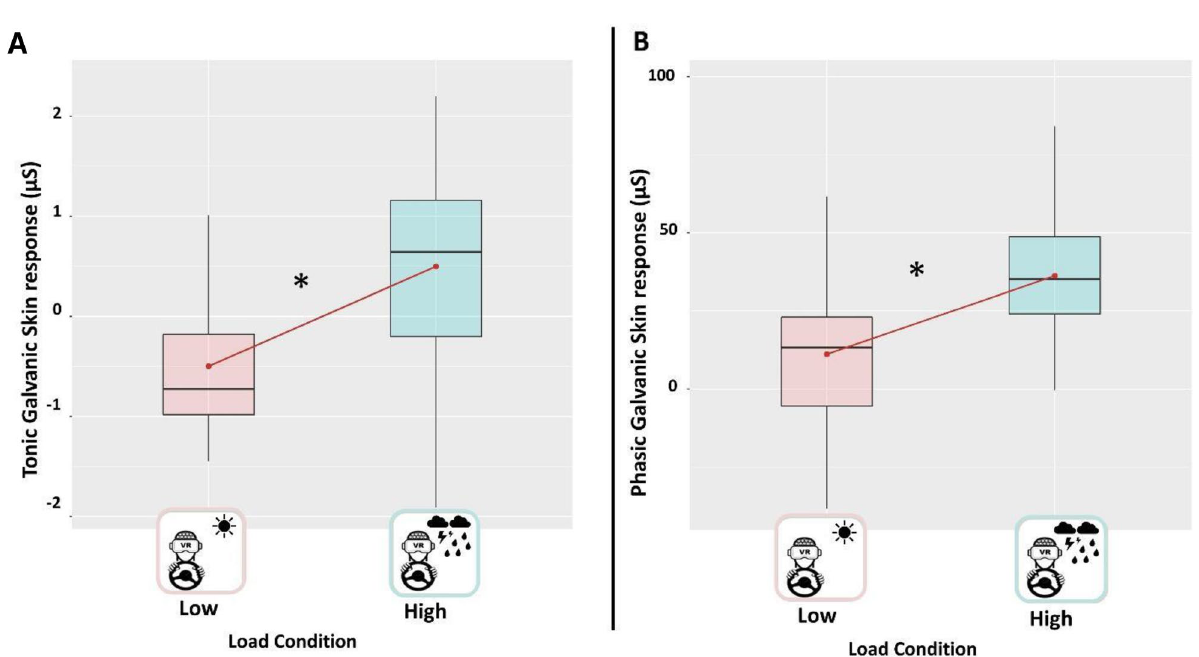
Figure 5. Boxplots representing ( A ) the tonic GSR averaged across sensory tasks for each Load Condition; ( B ) the phasic GSR averaged across sensory tasks for each load condition. The black asterisks indicate significant post-hoc tests while red dots and lines refer to the mean. The central line represents the median, the top and the bottom of the box are the first and third quartiles, and the whiskers are the interquartile range of the lower quartile and of the upper quartile multiplied by